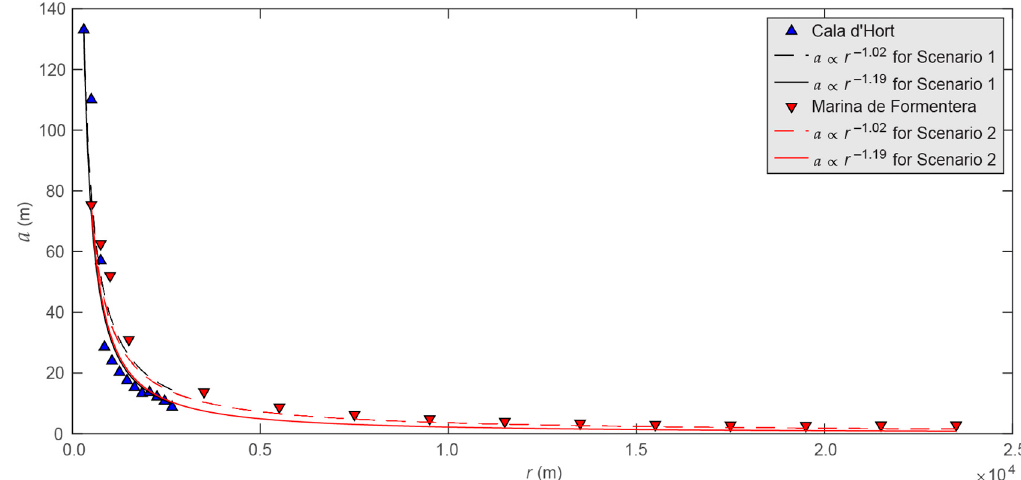
Figure 14. Comparison of wave amplitude a decay over radial distance r for both scenarios with maximum and minimum decay found by Abadie et al. [12].